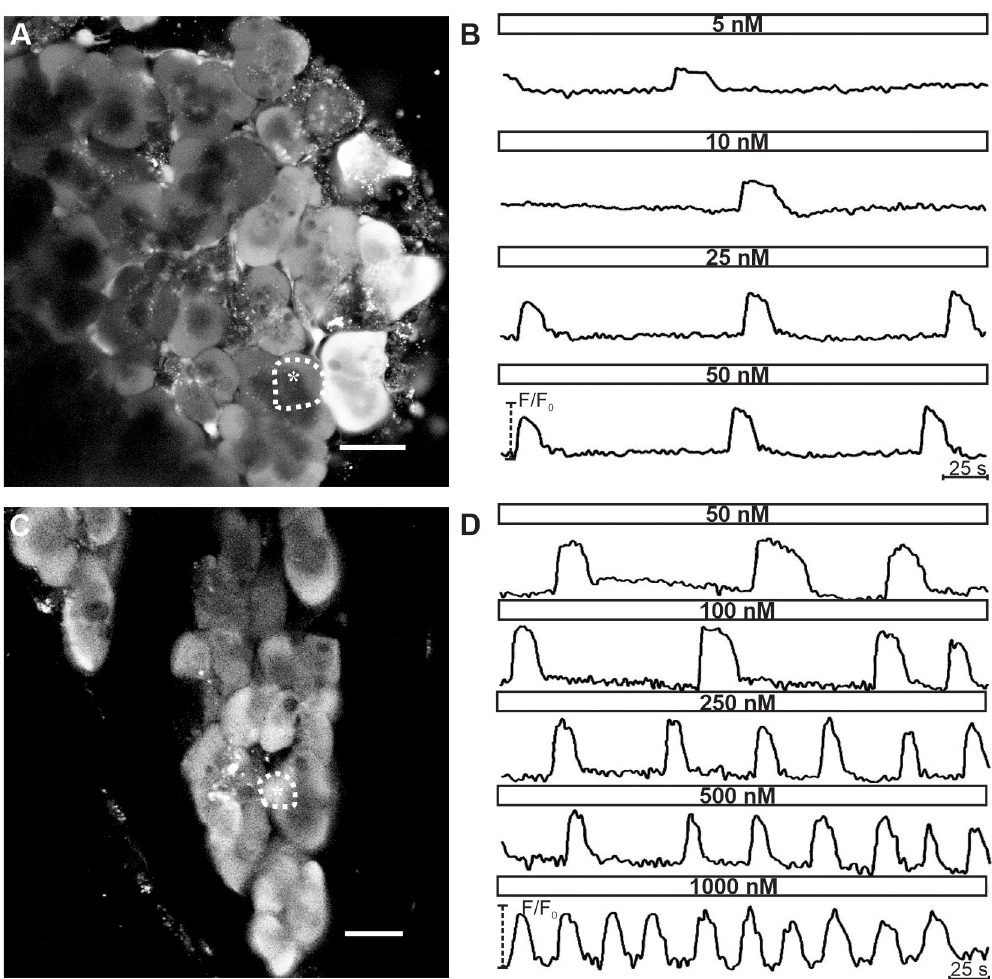
response to ACh concentrations ranging from 5 to 50 nM. The corresponding acinar cell is marked with thin broken line and asterisk in (A). (D) [Ca 2+ ] i oscillations in an acinar cell in response to ACh concentrations ranging from 50 to 1000 nM. The corresponding acinar cell is marked with thin broken line and asterisk in